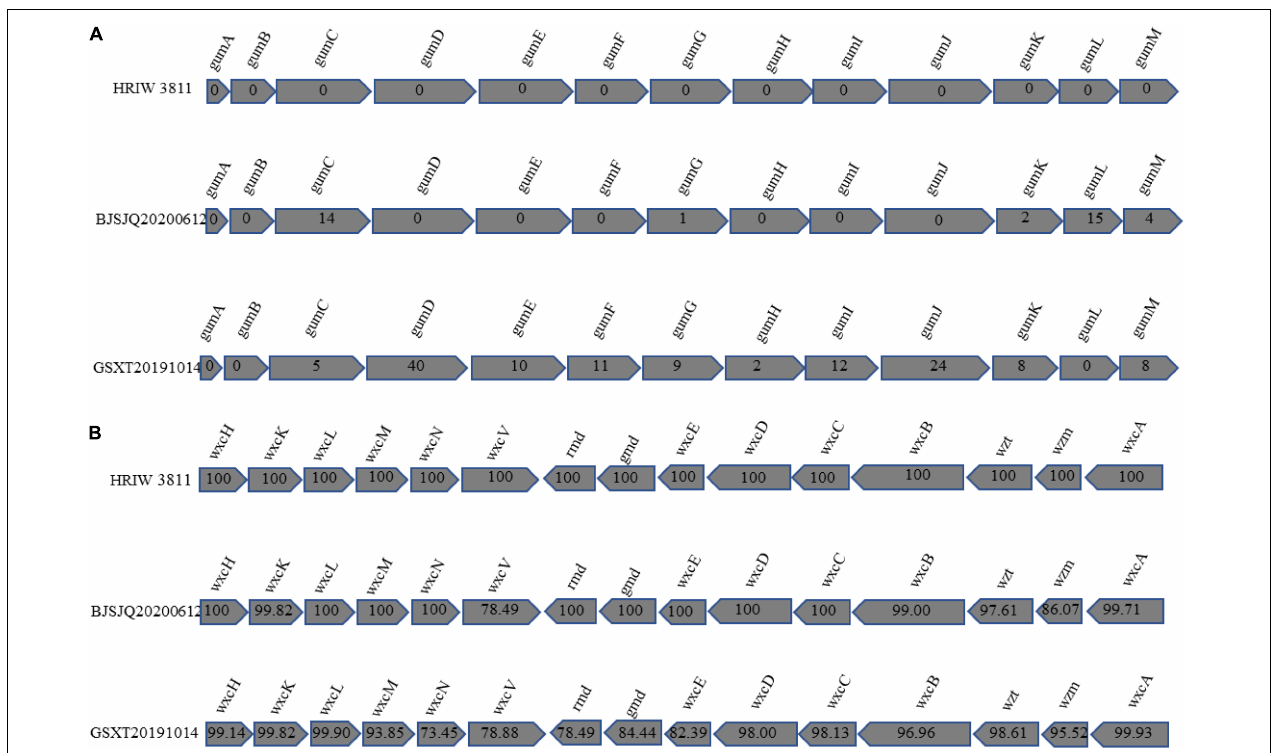
FIGURE 8 | Comparative representation of the organization of Xcc gene clusters directing the synthesis of xanthan and lipopolysaccharide. The Xcc genes involved in the synthesis of xanthan are symbolized by shaded arrows that illustrate the similarities in size, order, and direction of transcription among these genes. Conventional gene names are given above the arrows of homologous genes. (A) Genes gumB to gumM are required for xanthan synthesis. The numbers within the arrows provide the numbers of the nucleotides deviating by SNPs or insertion-deletion events from the BJSJQ20200612 and GSXT20191014 gene sequences compared to the HRIW 3811. (B) The genes wxcH , wxcL , wxcM , wxcN , wxcO , rmd , gmd , wxcE , wxcD, and wxcC are required for lipopolysaccharide synthesis. The numbers within the arrows show the percentage of nucleotide similarity among BJSJQ20200612, GSXT20191014 and HRIW